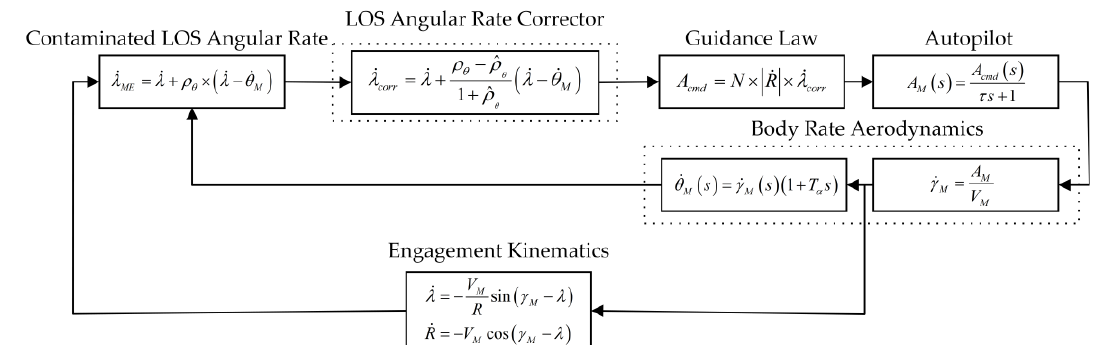
Figure 5. PN guidance system with LOS angular rate corrector.